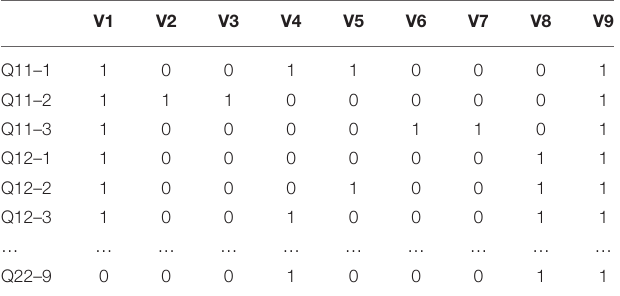
TABLE 2 | Design matrix of LLTM.